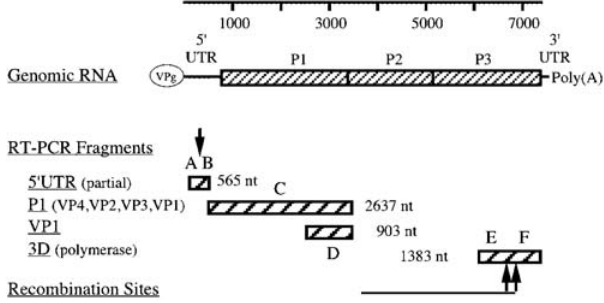
Figure 1. Genomic fragments of type 2 VDPVs amplified by RT-PCR for sequencing and phylogenetic analysis. The polyprotein encoded by the Sabin 2 genome is represented by a rectangle on the genomic RNA. The 5 9 UTR (partial), P1, VP1, and 3D polymerase regions that were amplified by RT-PCR and sequenced are represented by 4 rectangles with dark cross hatching below the genomic RNA. They correspond to nt 183 to 747, 748 to 3384, 2482 to 3384, and 5986 to 7368, respectively, of Sabin 2 (Acc: X00595). The downward pointing arrow indicates the start of the hypervariable region of 5 9 UTR. The upward-pointing arrow indicates the location of the genetic recombination in the 3D polymerase gene. The letters R1 through R6 correspond to the separate regions used for sequence comparisons and phylogenetic analysis as shown in Figs. 2, 3 and 4.